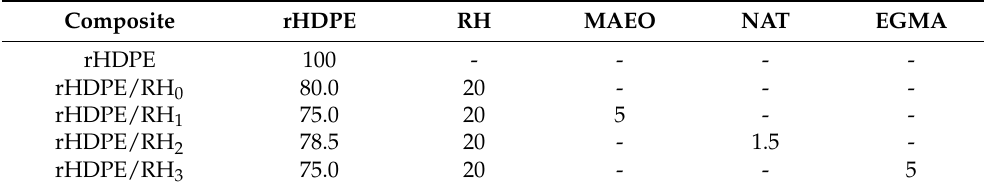
Table 2. Recycled polyethylene/rice husk composite formulations